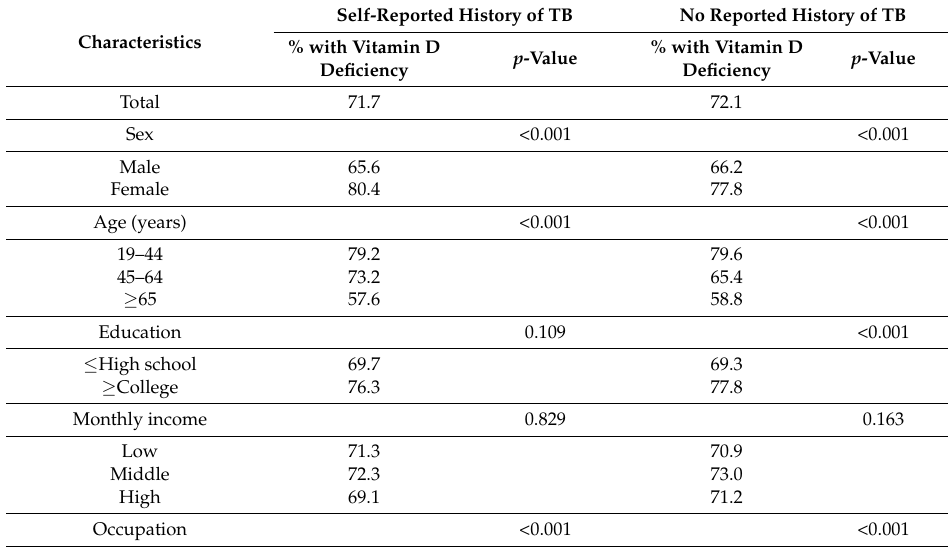
Table 2. Prevalence of vitamin D deficiency by subject characteristics in the TB and control